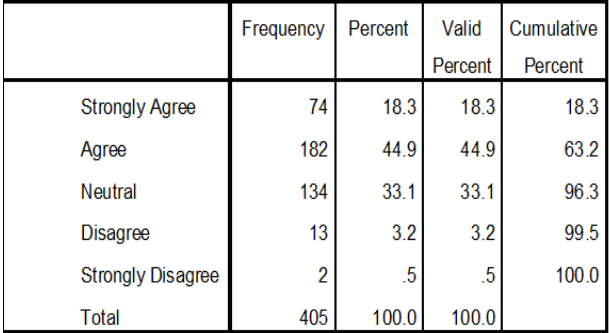
Figure 3. The Company is making higher profits after implementation of cloud and IoT based